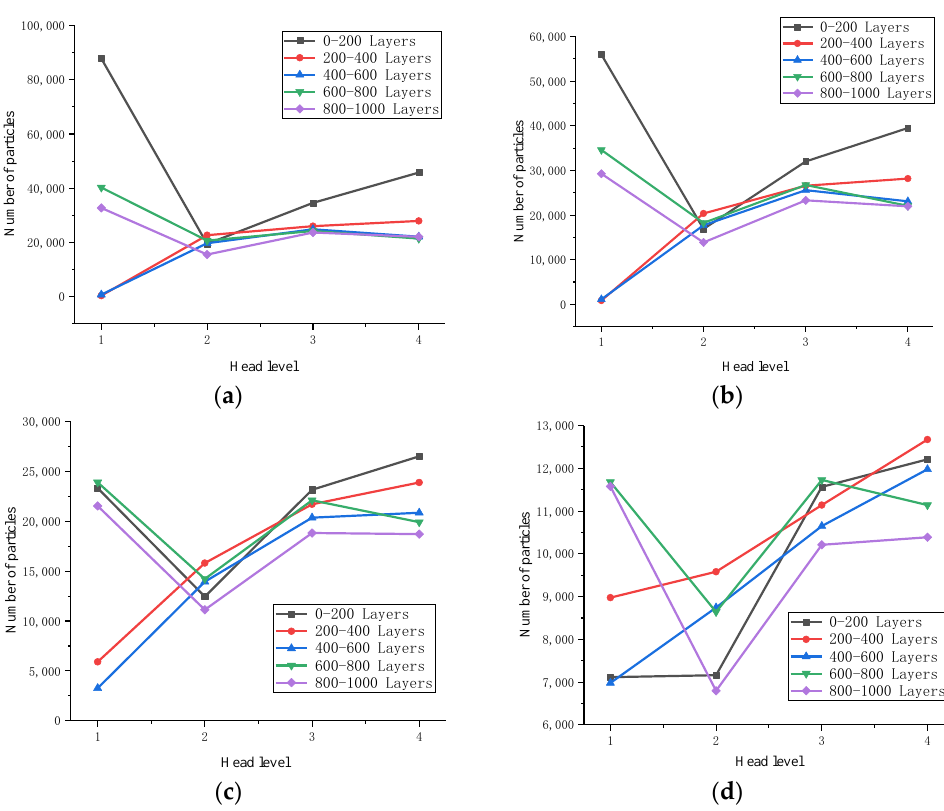
Figure 16. Variation in the number of the fine particles percolated with the 70% fine content. ( a ) Particle size: 0 – 10 µm; ( b ) Particle size: 10 – 20 µm; ( c ) Particle size: 20 – 40 µm; ( d ) Particle size: 40 – 75 µm.